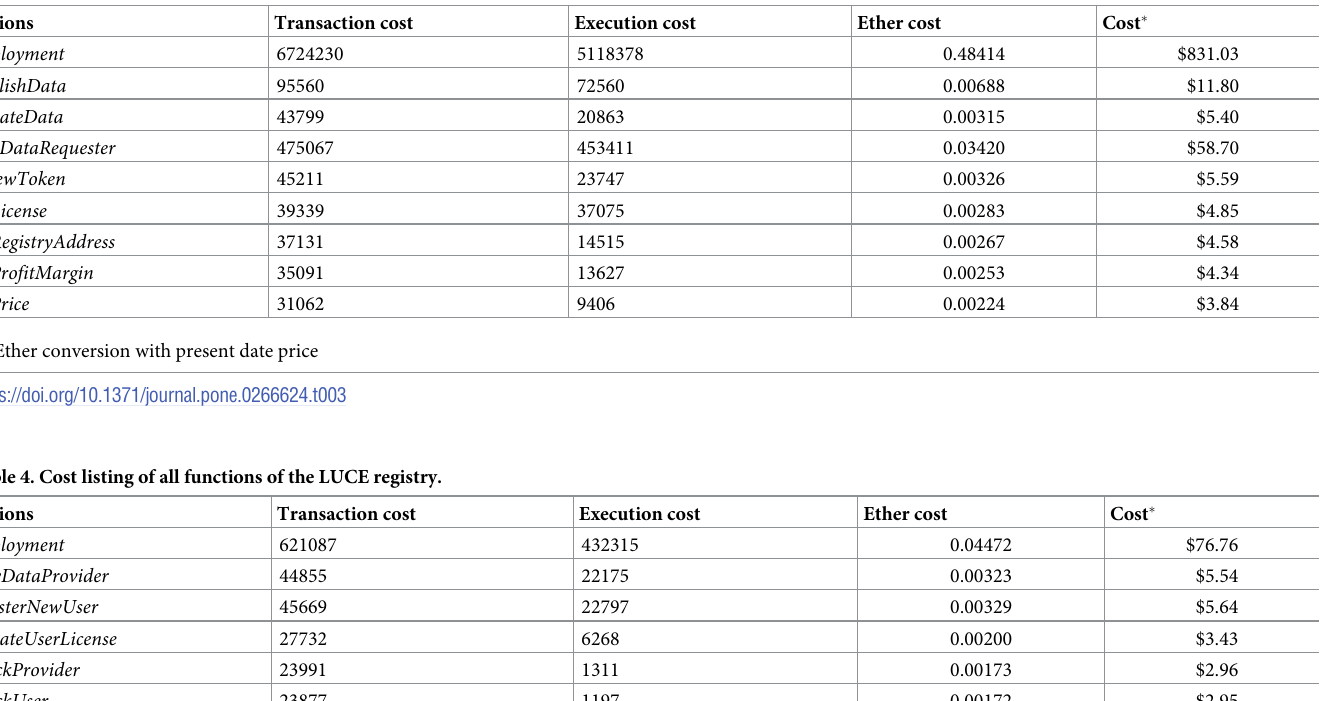
Table 3. Base cost for the core functions of LUCE.